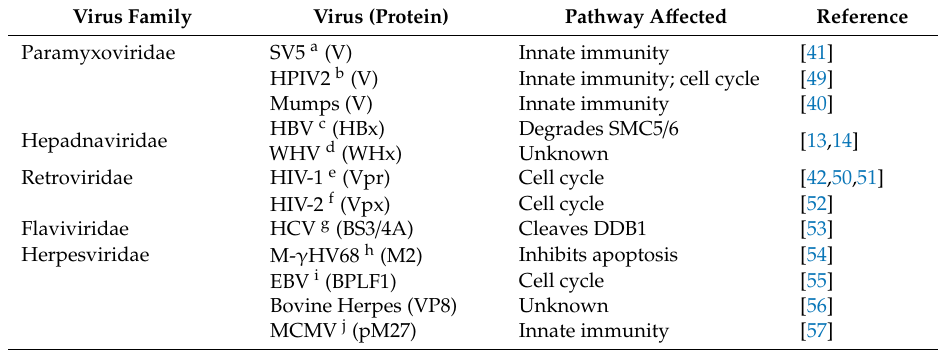
Table 1. Viral proteins that interact with CUL4-DDB1: Proteins encoded by several viruses interact directly with CUL4-DDB1 and benefit virus replication. For example, several paramyxoviridae express V proteins that target signal transducer and activator of transcription (STAT) proteins for degradation via CUL4-DDB1 to inactivate the innate immune response. Other viral proteins and the cellular functions targeted are also listed. Table modified with permission from Reference